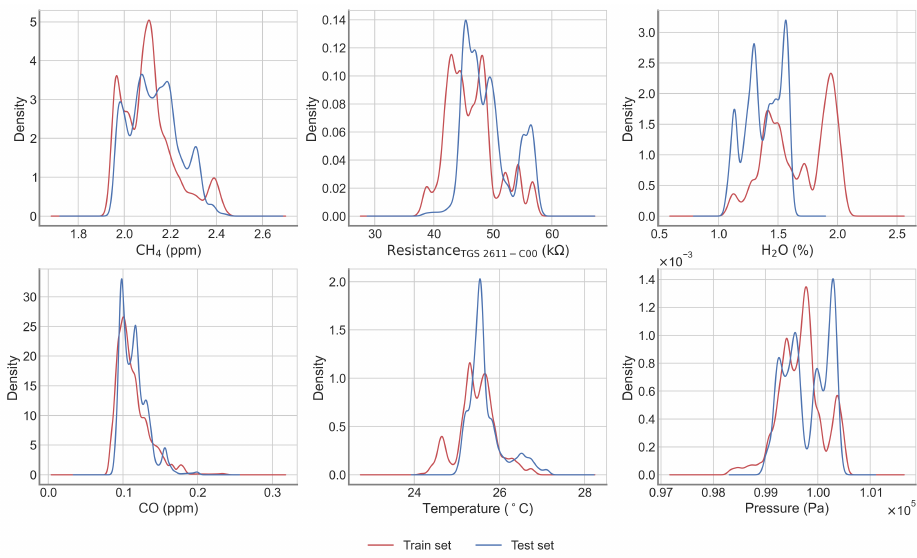
Figure A4. Density distribution of the training (red) and test (blue) set for the best case